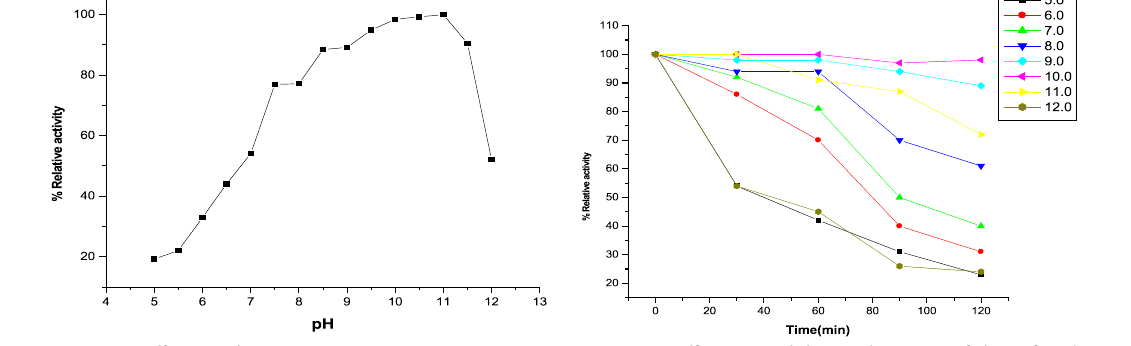
Fig. 2. pH effect on the LKE-021 activity Fig. 3. pH effect on stability and activity of the refined